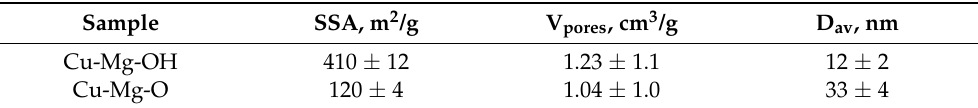
Figure 3. Low-temperature nitrogen adsorption/desorption isotherms ( a ) and pore size distribution ( b ) for the Cu-Mg-OH xerogel and Cu-Mg-O oxide sample. Table 1. Low-temperature nitrogen adsorption data for the Cu-Mg-OH xerogel and Cu-Mg-O oxide samples.